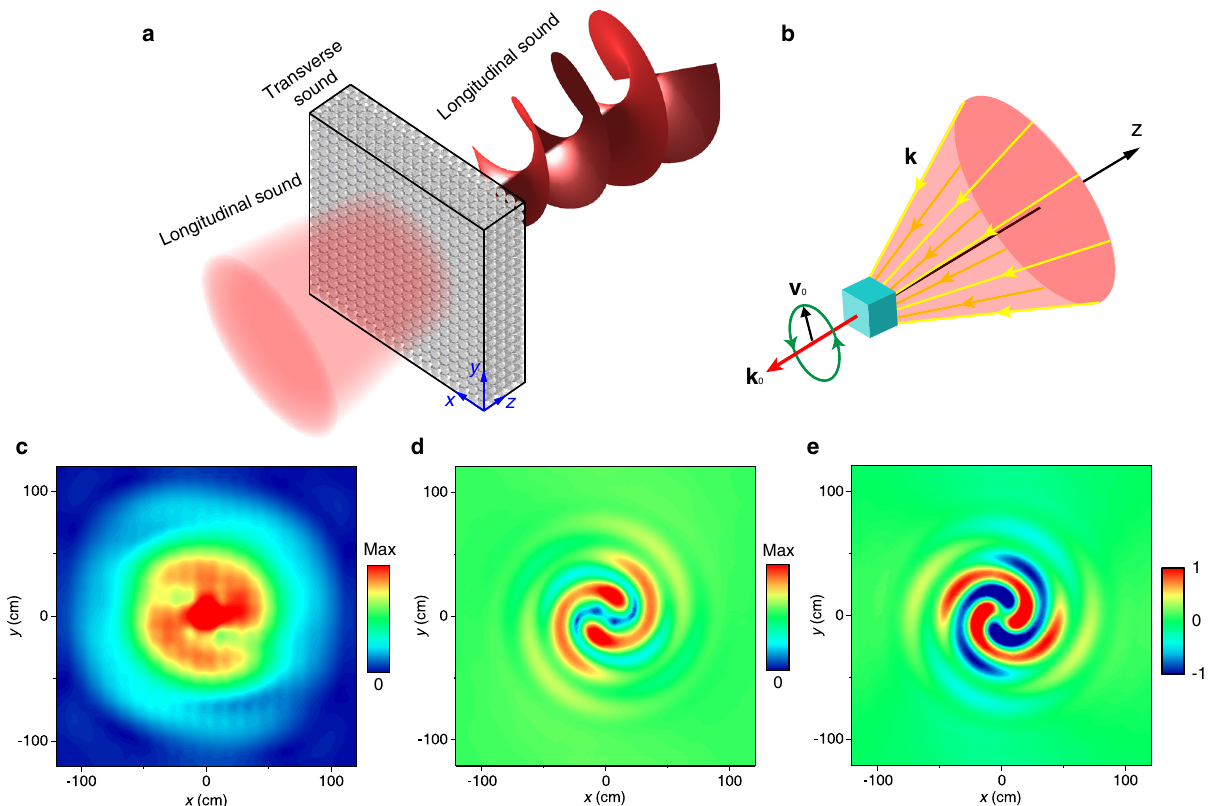
Fig. 6 Spin-dependent vortex generation enabled by SOI in real space. a The schematic of the scattering system. One unit cell is removed from the center of the metamaterial to create a dipole scatterer. A Gaussian beam is normally incident on the metamaterial. b The schematic of the scattering of transverse sound inside the metamaterial. The blue cube denotes the scatterer. c The amplitude of the transmitted pressure fi eld. d The velocity amplitude in the micropolar effective medium due to the interference of s ¼ (cid:2) 1 scattered fi eld with the background fi eld. e The real part of the s ¼ (cid:2) 1 scattered velocity fi eld in the micropolar effective